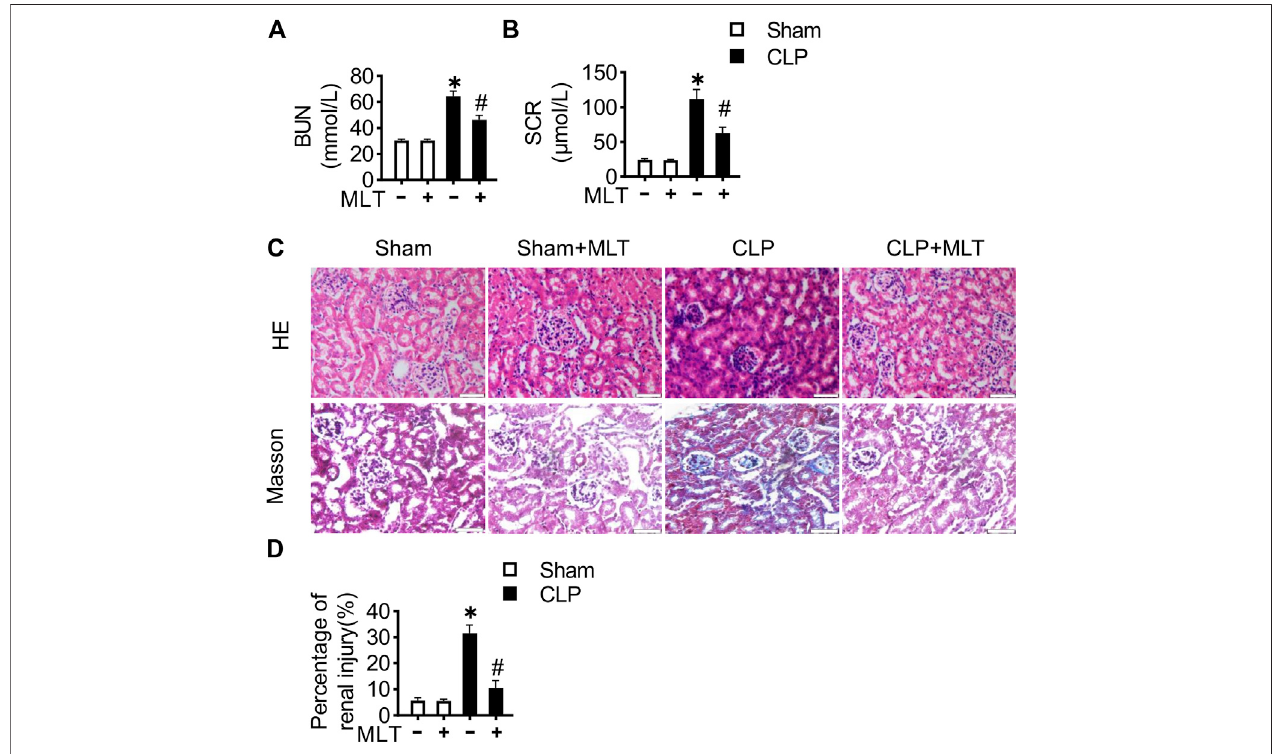
FIGURE 1 | Melatonin alleviates renal dysfunction in sepsis-induced acute kidney injury. 8-week-old mice were treated with melatonin (25 μ g/ml) dissolved in drinkingwater for 14 days. Effects ofMLT on the concentration of serum (A) BUN and (B) SCR (* vs. sham, p < 0.05; # vs. CLP, p < 0.05). (C) Representative images of HE stainingand Massontrichromestainingofkidneytissues (scale bar (cid:1) 50µm). (D) Percentage ofrenalinjurywasquanti fi ed (*vs.sham, p < 0.05;#vs. CLP, p < 0.05).